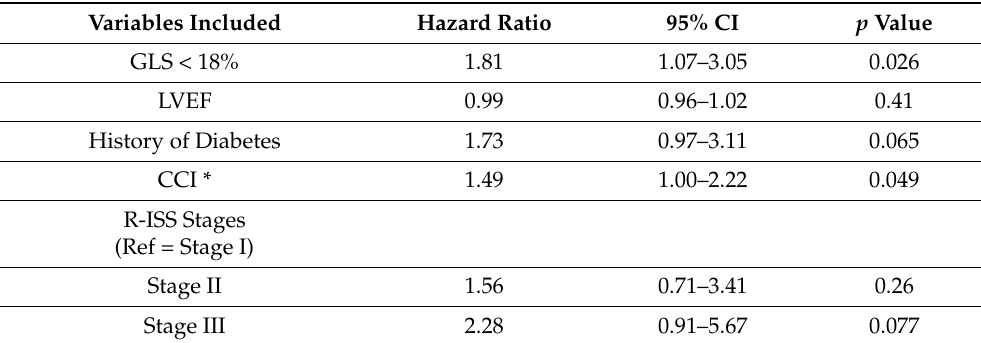
Table 4. Multivariable Cox regression model for